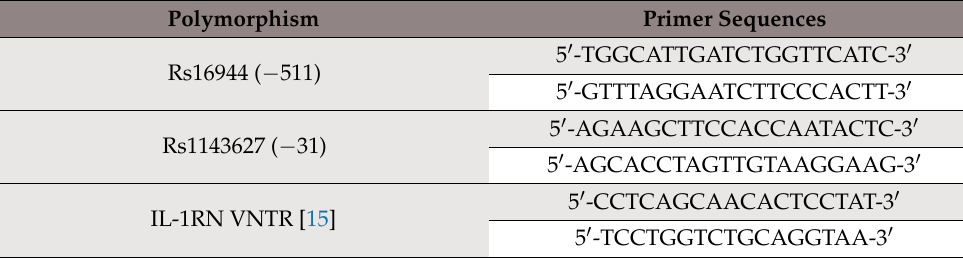
Table 1. Primers used for PCR.